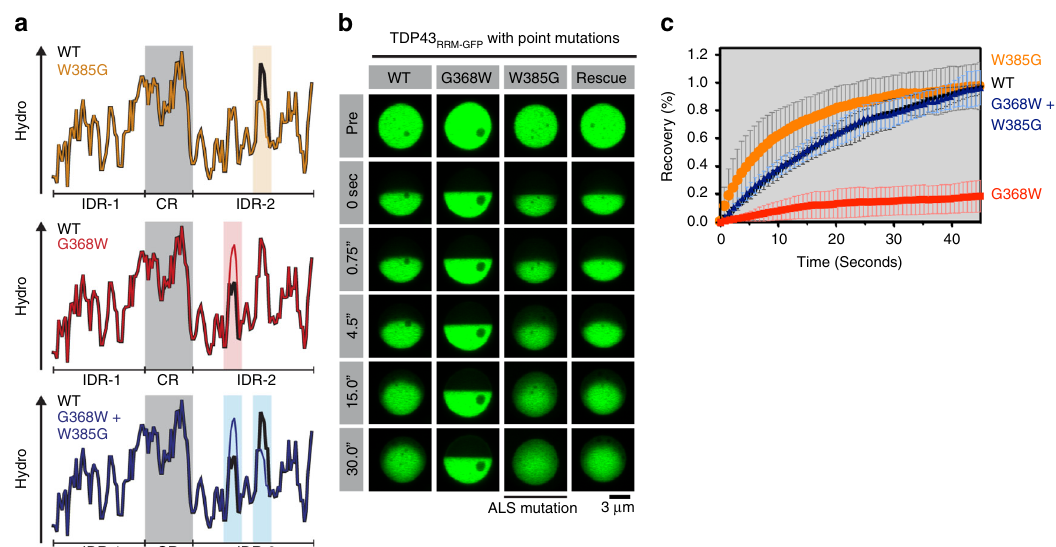
Fig. 6 Compensatory mutations rescue altered phase dynamics caused by primary mutations. a Plots showing the effects of single- and double-point mutations on local hydrophobicity in the TDP43 CTD. b , c Material properties of TDP43 RRM-GFP droplets with single and double CTD mutations formed by transient transfection in HEK-293T cells. Plot markers represent mean values and error bars standard deviation ( n ≥